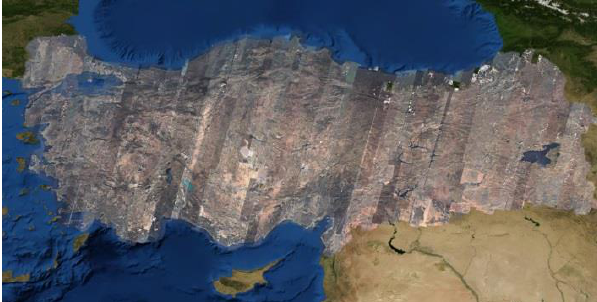
Figure 6. Mosaic image of Turkey.